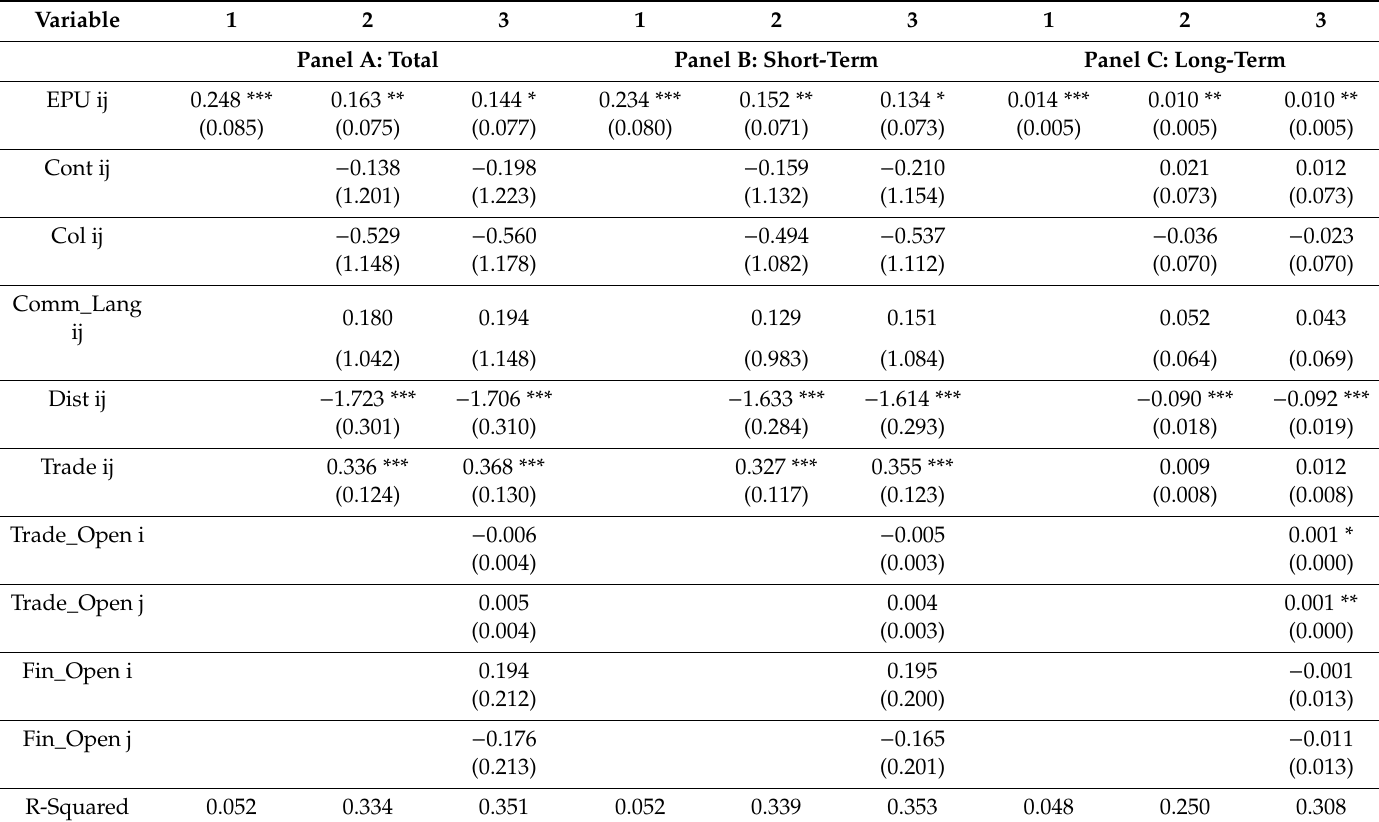
Table 1. Determinants of net-pairwise fear shock